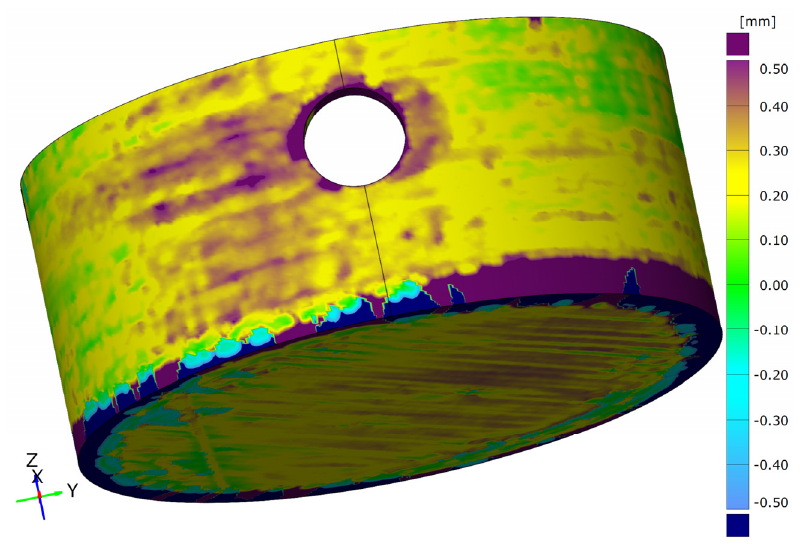
Figure 11. Target/actual surface comparison for the robot-produced test specimen “RG” with the deviations of the rough surface in the lateral component area around the hole as also seen in Figure 10, the soil structure known from the CLSM measurements (Figure 9) and the warping in the edge area.